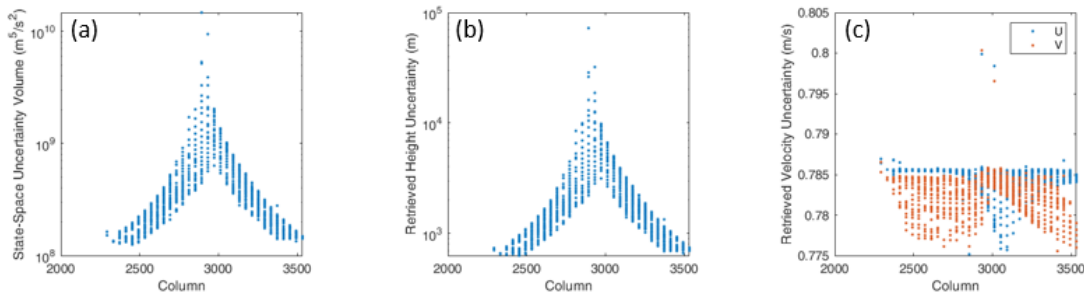
Figure 11. The state-space uncertainty volume ( a ) and state standard errors ( b ) and ( c ) depend on the geometry of the LEO satellite with respect to the GEO satellite. The state-space uncertainty volume and standard error for the retrieved height become infinite in the singular geometry. The case shown is MOD2019057.1510.061 (MODIS Band 31) paired with GOES-16 Full Disk Band 14. The height uncertainties are larger than those with MODIS Band 1 paired with ABI Band 2 to begin with due to the larger pixel footprint of the IR channels (four times larger in comparison to the finest resolution) and asymptotically approach infinity as the singular geometry is approached. The longer refresh time for a Full Disk scene compared to a CONUS scene will reduce the velocity uncertainties; but real-world features can change shape over longer periods of time, which is an error not represented here.